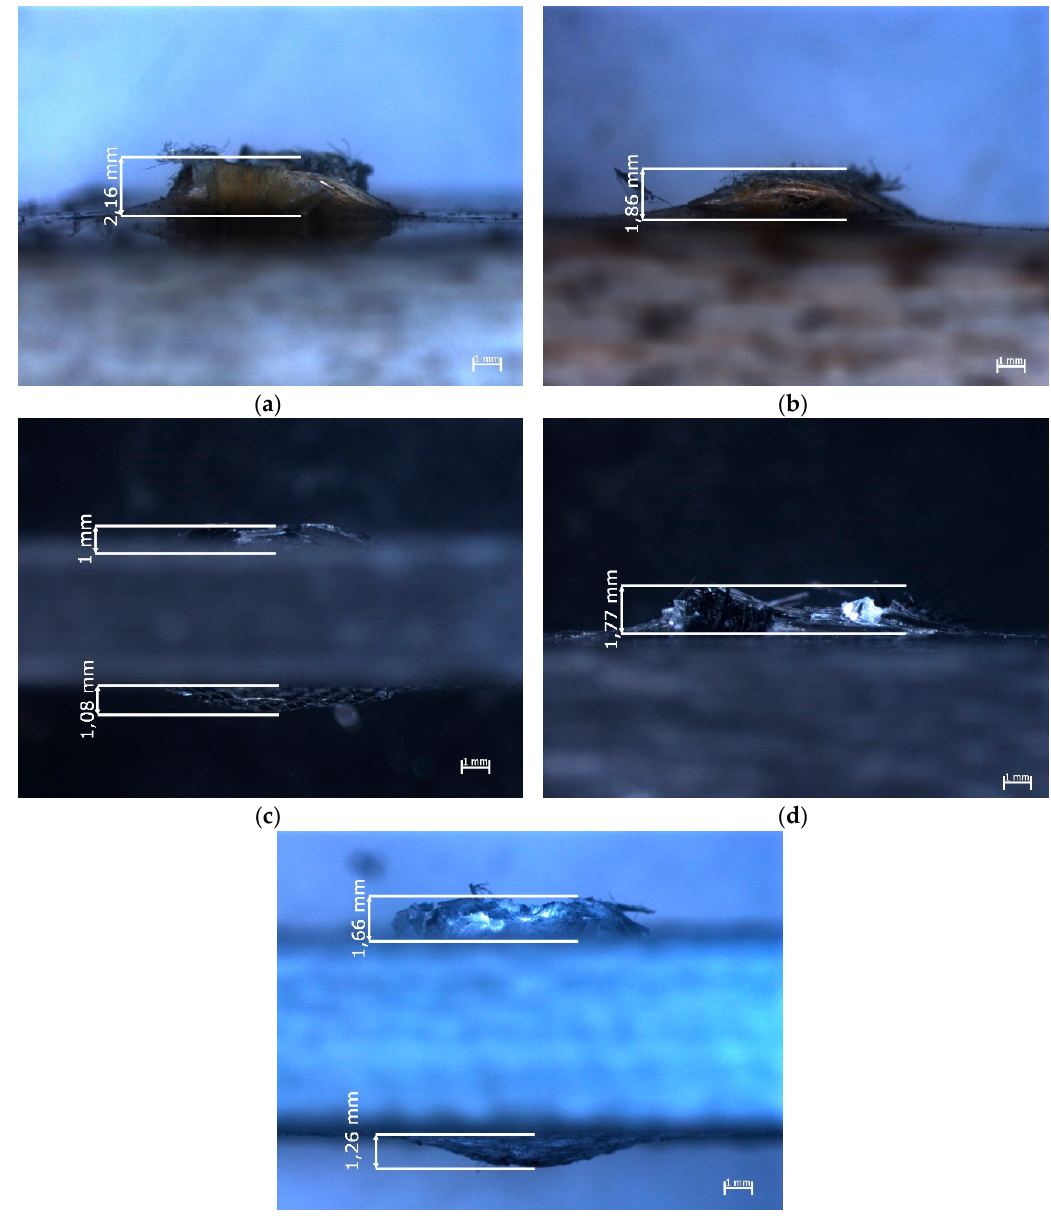
Figure 6. Epoxy composites with reinforcement made from the following fibers: ( a ) Twaron 2200, ( b ) Kevlar 49, ( c ) Pyrofil TR30 S, ( d ) HR 12K, ( e ) Dyneema SK 60, after impact of the ogival striker—perpendicular view point to the impact axis.